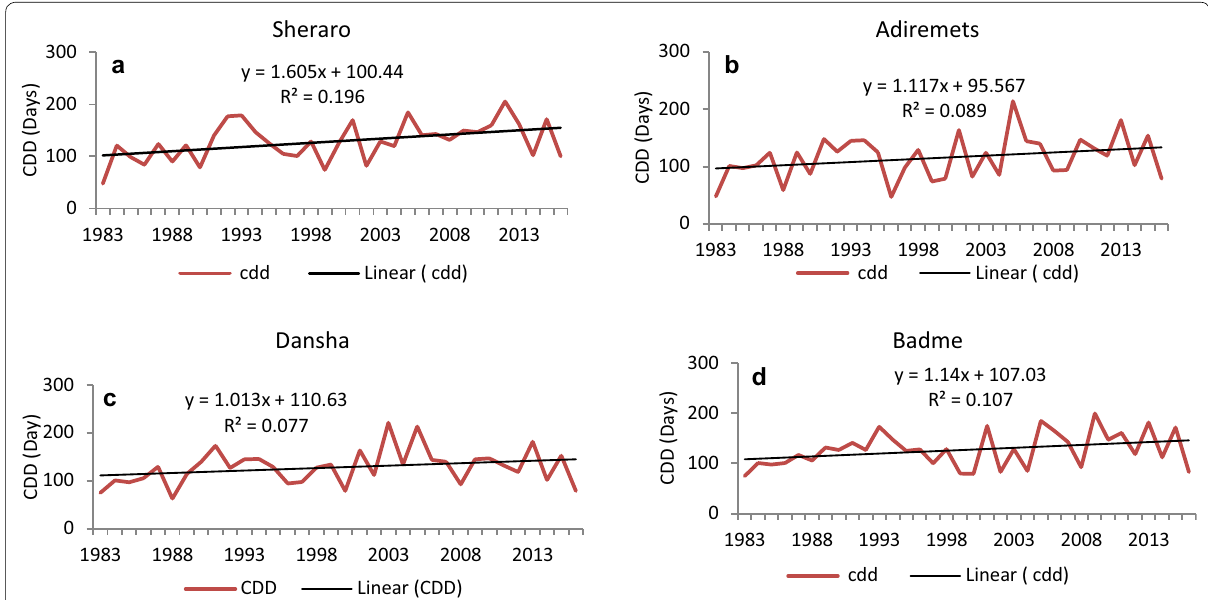
Fig. 10 Consecutive dry days (CDD) of different stations in the study sites; a Sheraro, b Adiremets, c Dansha, d Badme, e Dedebit and f